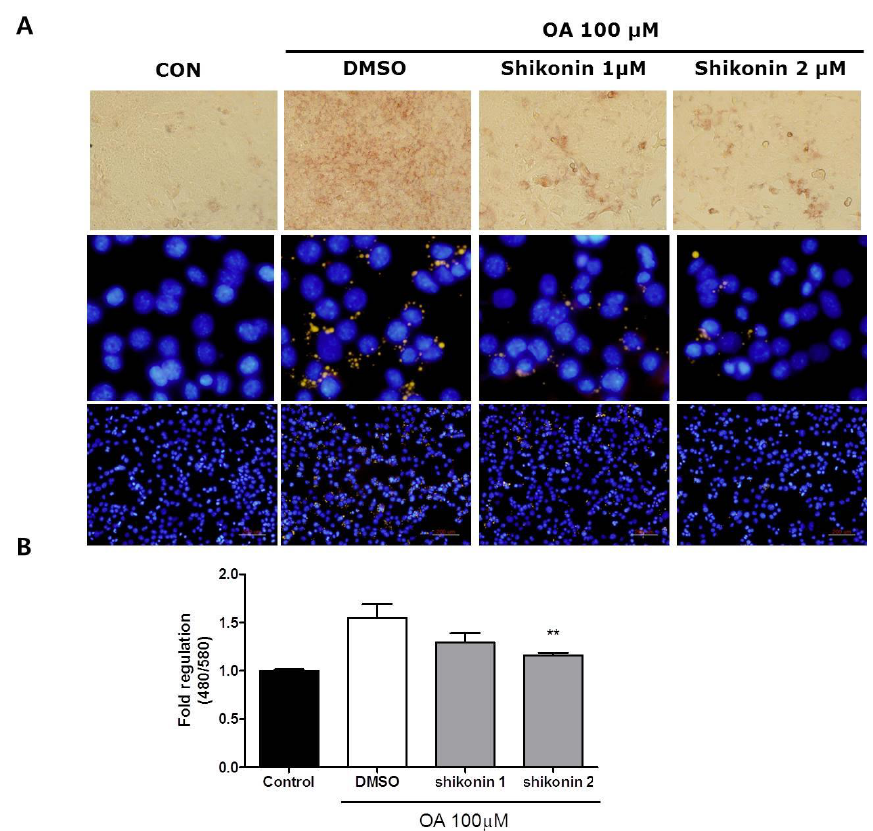
Figure 2. Shikonin inhibits oleic acid-induced lipid accumulation in Hepa 1-6 cells. ( A ) The lipid content was assessed by Oil Red O staining and Nile Red staining. ( B ) Quantitative assessment was measured by flow cytometry. The result was expressed as mean ± standard error of the mean (SEM). **, p < 0.05. Nutrients 2020 , 12 , x FOR PEER REVIEW